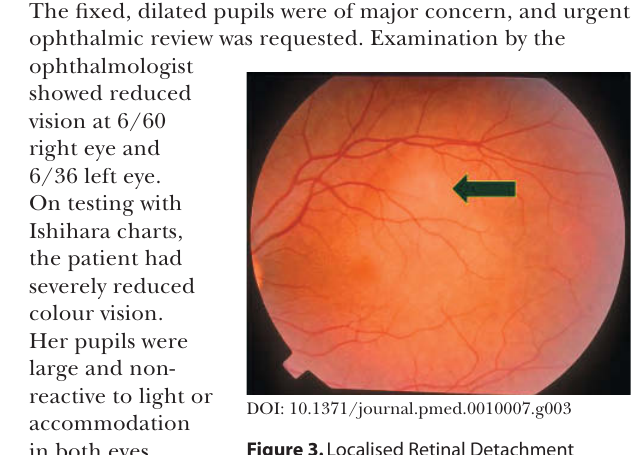
Table 2: What to Do When the Patient Is Not Getting Better Cause Explanation Wrong organism.